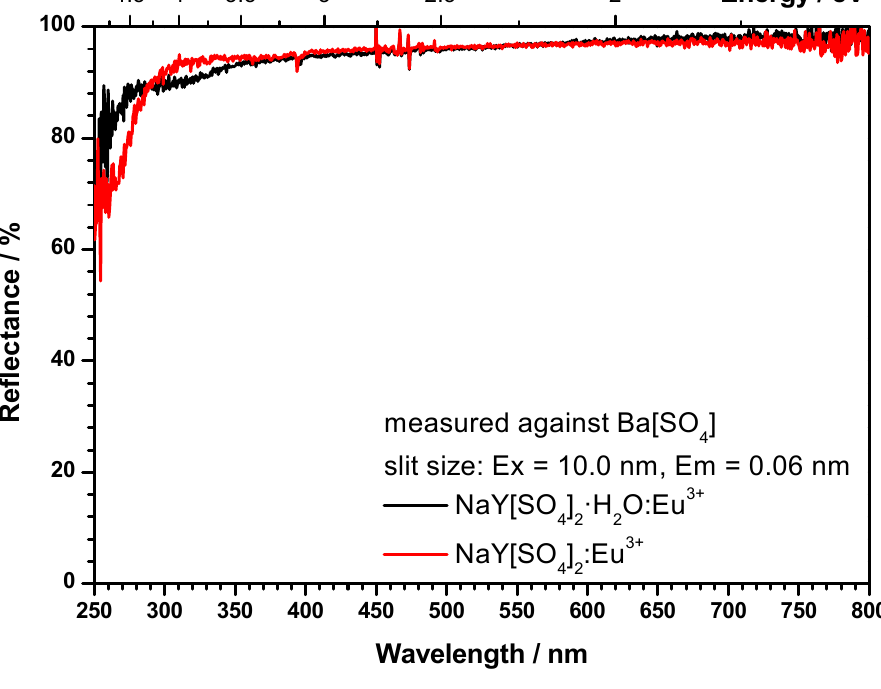
] ∙ H O:Eu 3+ and 4 2 2